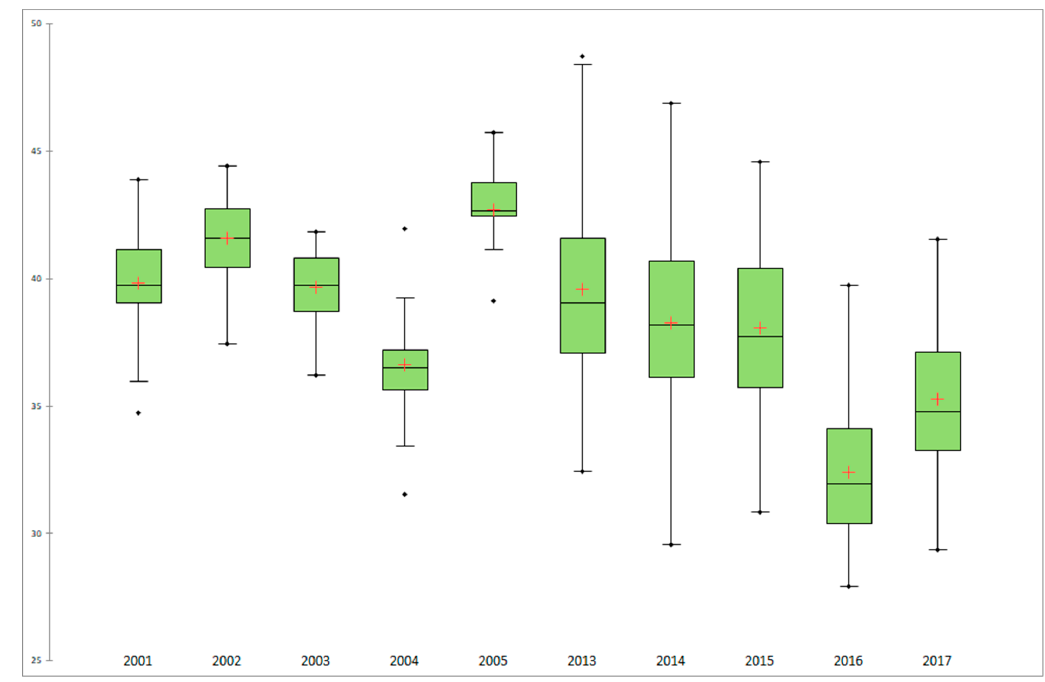
Figure 8. LST boxplots for the Confluence site (red cross: average; black dots: min and max values).